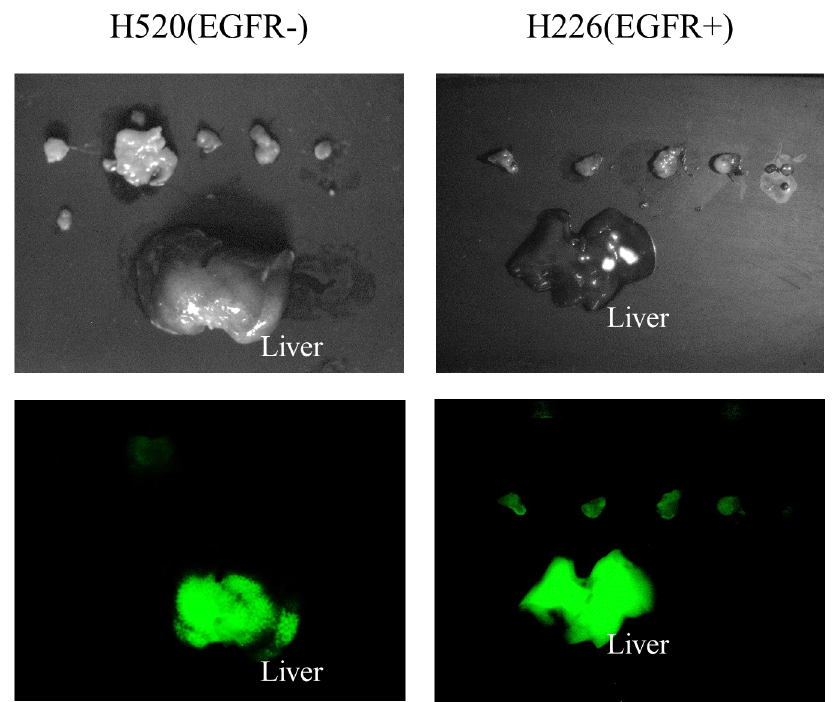
Fig 6. Ex vivo fluorescence images of EGFR- and EGFR+ lymph node metastases. Ex vivo fluorescence images showed higher fluorescence signals in EGFR+ lymph node metastases than in EGFR- ones.